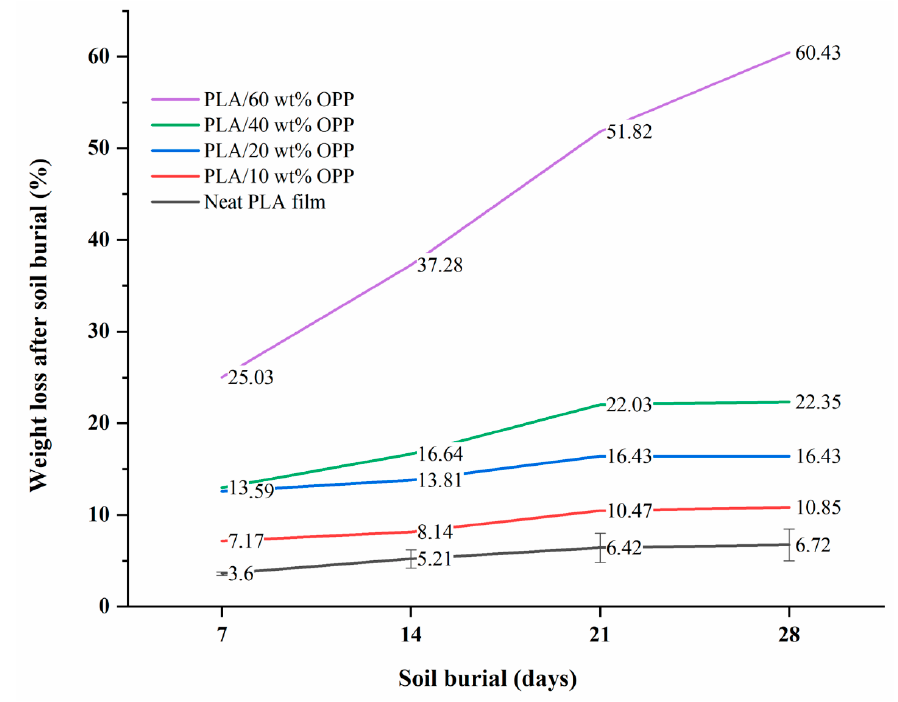
Figure 6. Weight loss percentage of composites over days after soil burial. Table 1. Physical appearance of composites before and after soil burial test.